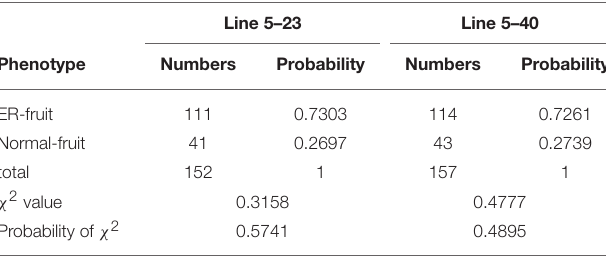
TABLE 1 | χ 2 test for the epidermal reticulation (ER) fruit trait of two independent segregating